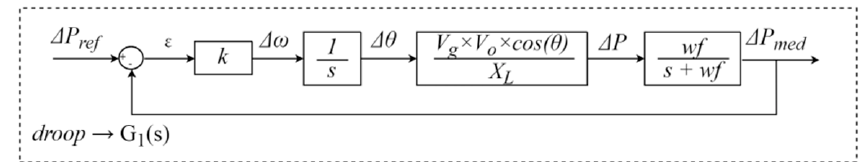
Figure 4. Block diagram of the droop controller.